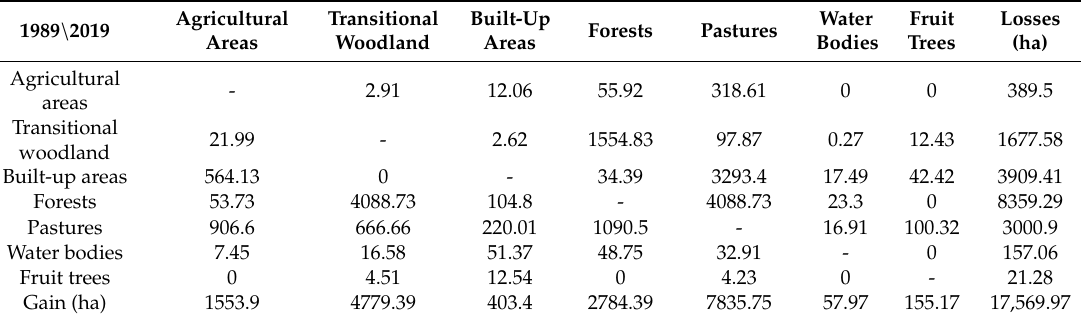
Table 2. Markov matrix for the period